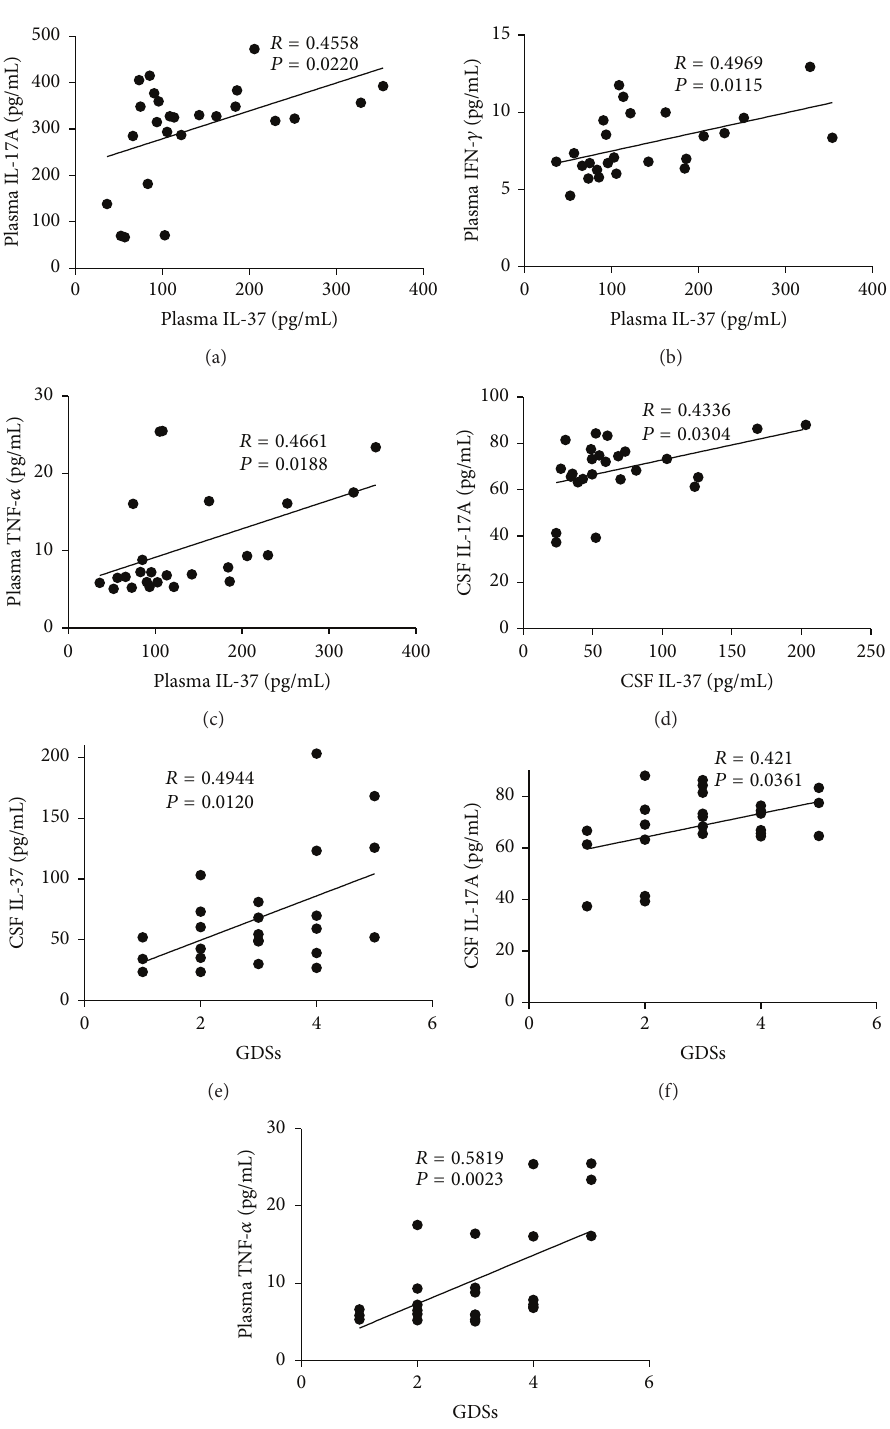
Figure 3: Correlation analyses between the levels of cytokines and the values of GDSs in those patients. The concentrations of plasma IL-37 were positively correlated with the levels of IL-17A (a), IFN- 𝛾 (b), and TNF- 𝛼 (c) in those patients. The levels of CSF IL-37 were positively correlated with the levels of CFS IL-17A (d) in those patients. The concentrations of CSF IL-37 (e) and IL-17A (f) as well as plasma TNF- 𝛼 were positively correlated with the values of GDSs in those